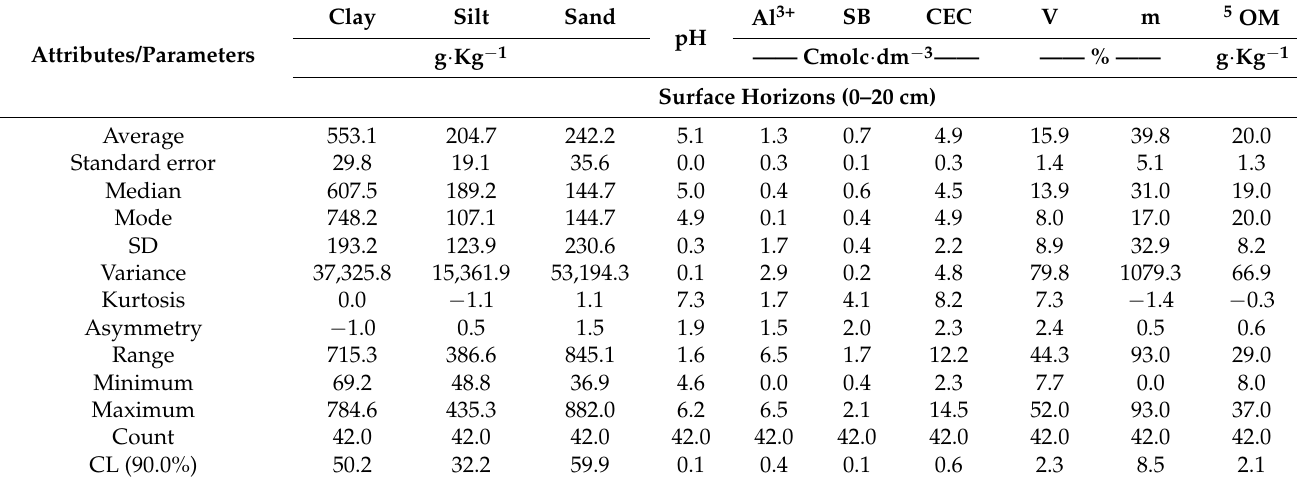
Table 2. Descriptive statistics of the studied subsurface soil